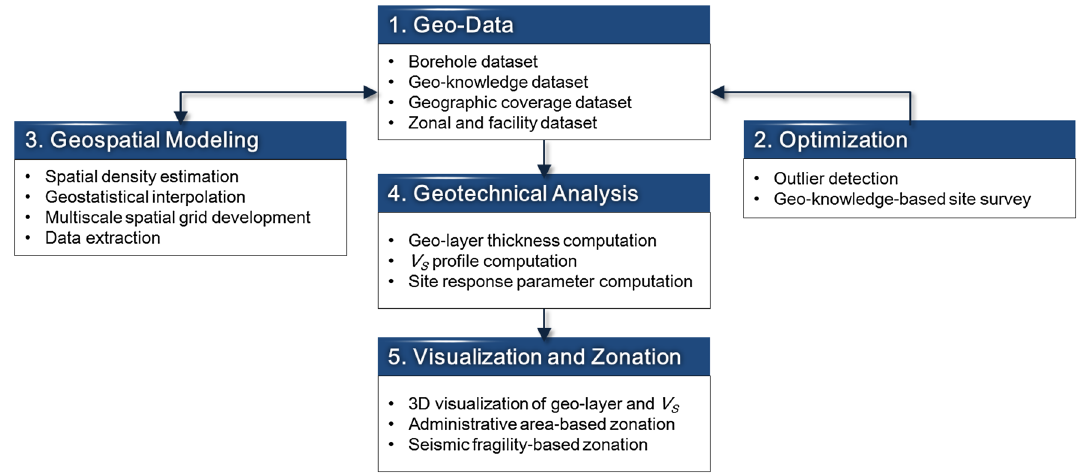
Fig. 1 Advanced GIS-based framework for the optimum estimation of local site